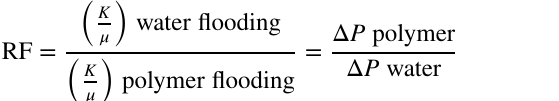
Fig. 9 Oil recovery factor for water and polymer flooding